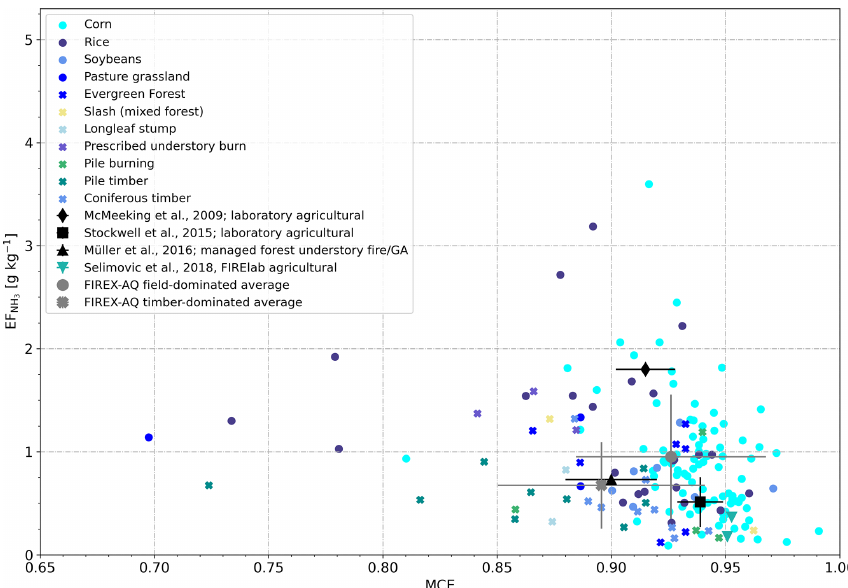
vs. MCE as measured for 66 agricultural fires (circles: field-dominated fuels, crosses: timber-dominated Figure 7. Scatter plot of EF NH 3 fuels) and obtained from four literature sources. , EF NH and MCE as measured during FIREX-AQ for two prescribed grassland fires in the Central United States and one Table 3. EF NH x 3 prescribed forest fire in the Southern United